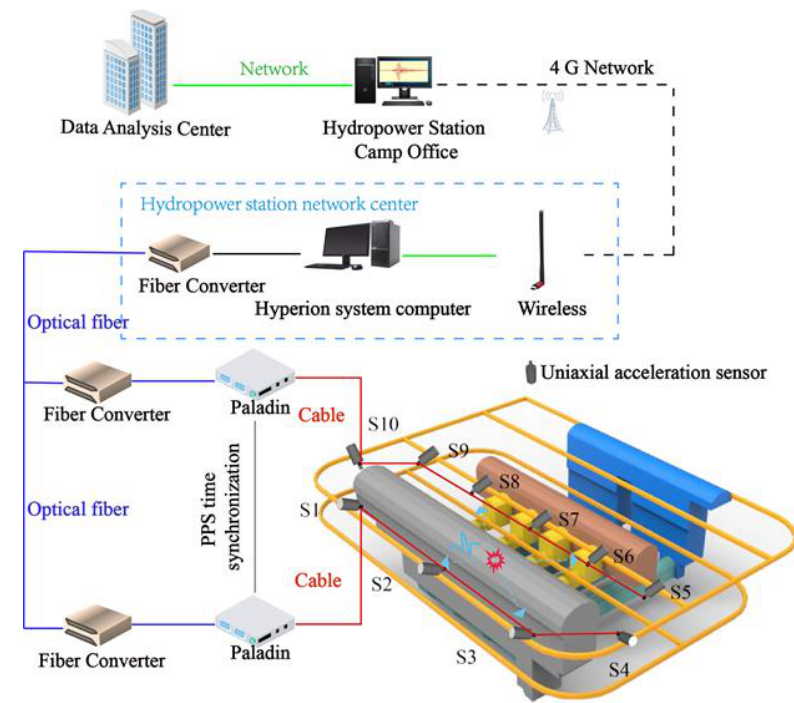
Figure 3. Network topology of the MS monitoring system for the underground powerhouse.